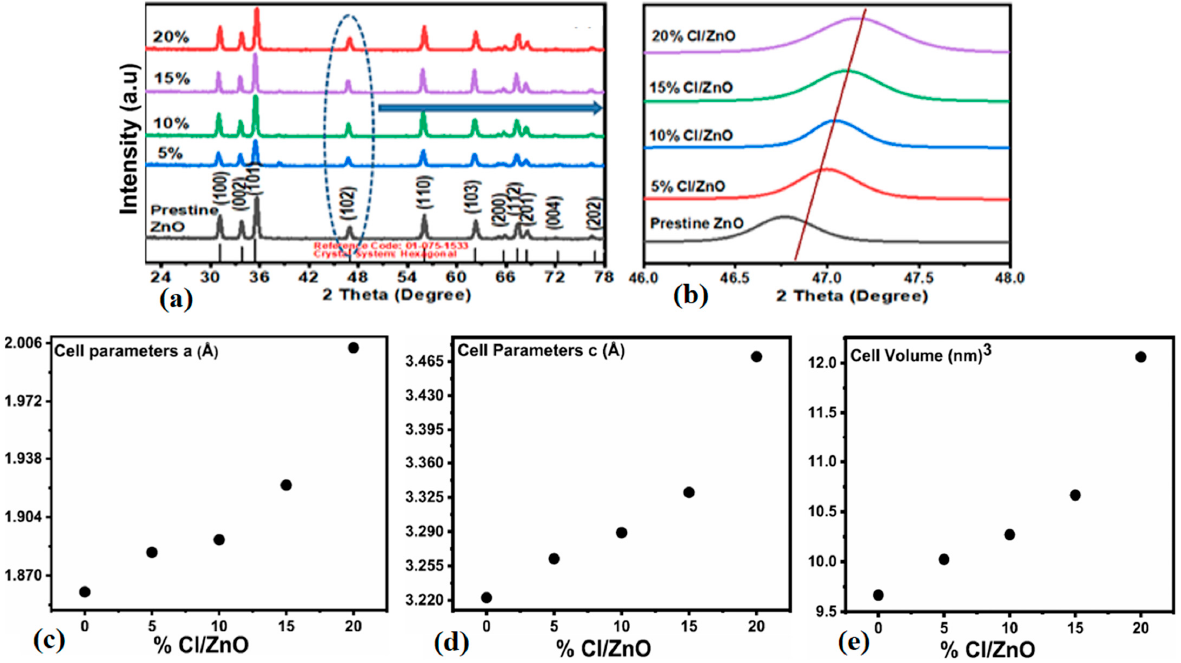
Figure 1. ( a ) XRD patterns for pure and Cl − -doped ZnO nanostructures, which can be indexed as a single phase of wurtzite ZnO structure using reference code (01-075-1533). ( b ) The observed increasing shift in peak at 2 θ angle of 47.452 degrees. ( c , d ) Cell parameters and ( e ) cell volume of ZnO:Cl nanostructures.